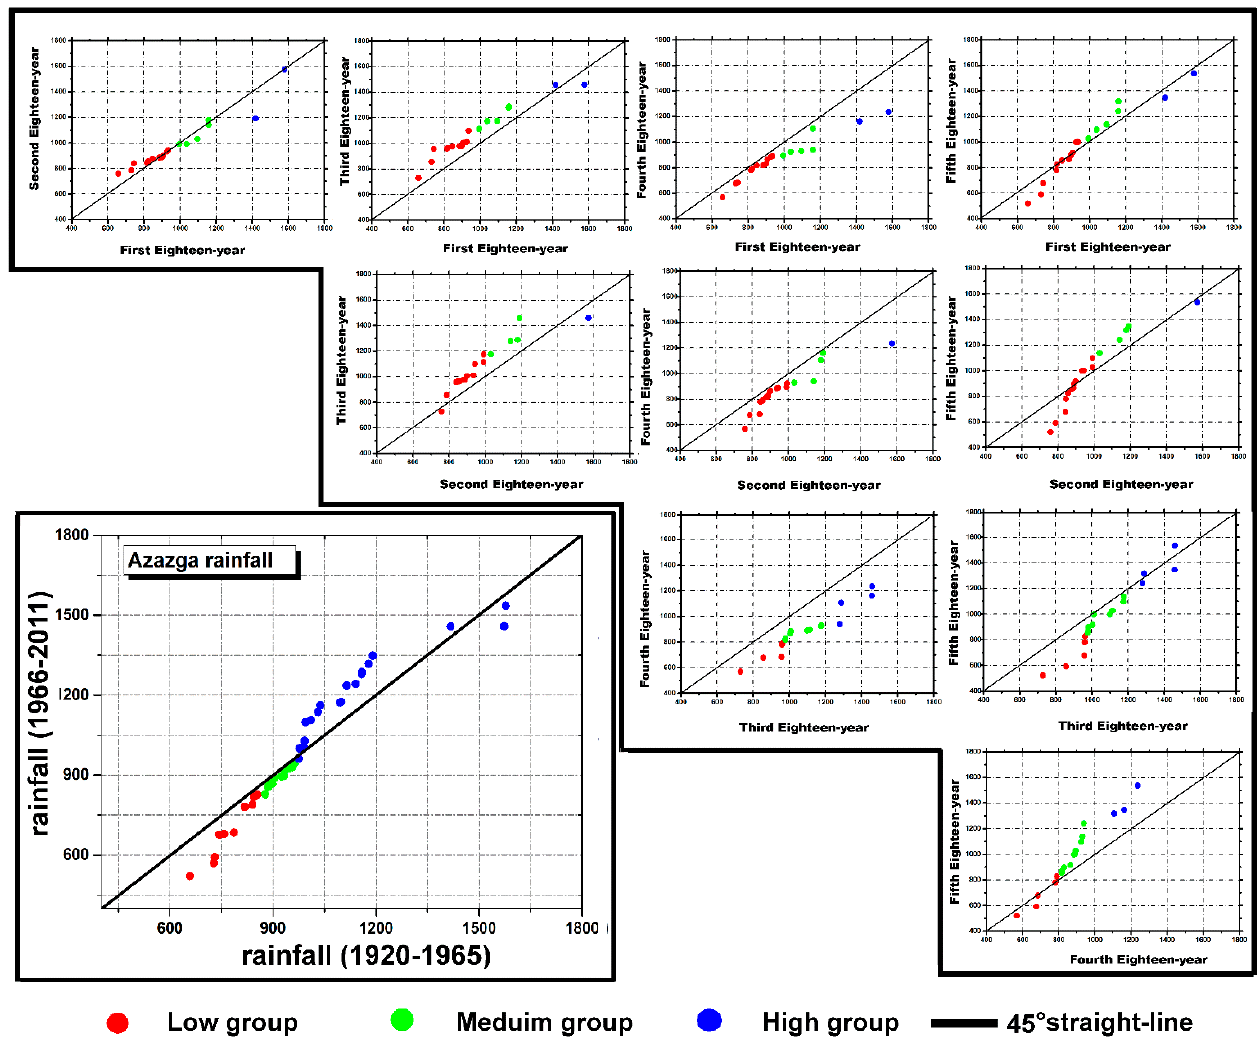
Figure 5. Triangular trend analysis methodology applied on rainfall series of Azazga.